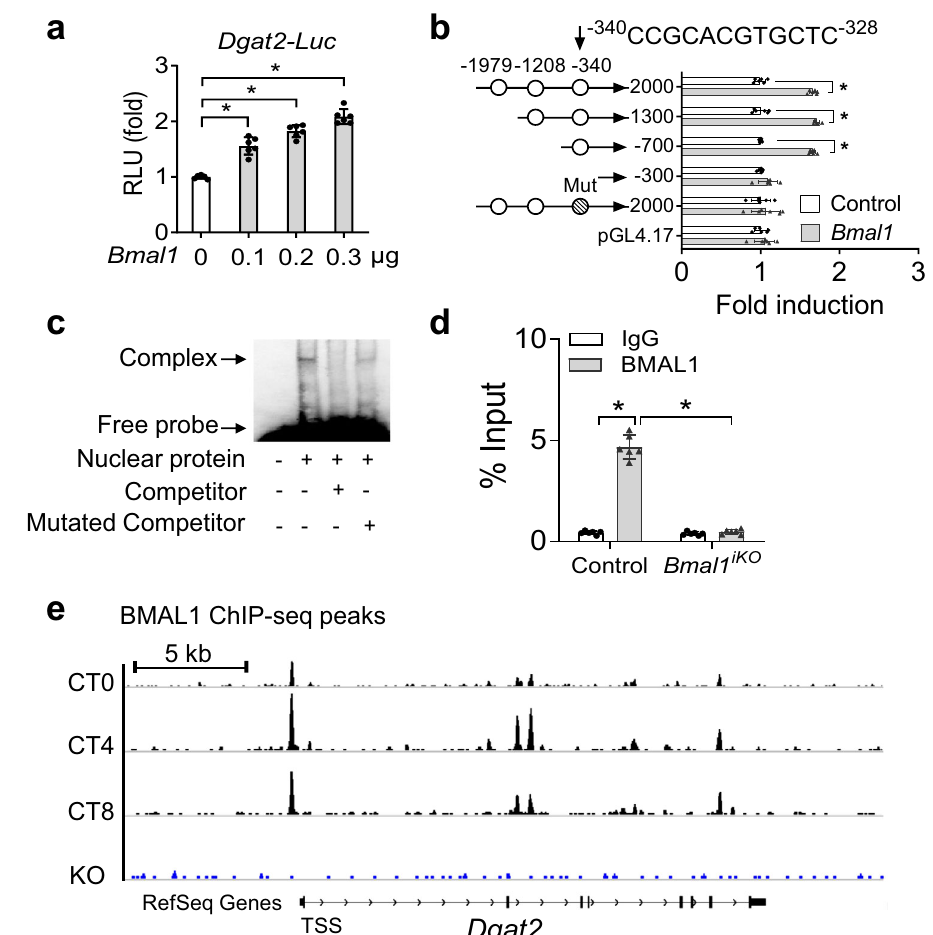
Fig. 6 BMAL1 regulates the transcription of Dgat2 . a Bmal1 dose-dependently induced Dgat2 transcription in luciferase reporter assays. NIH3T3 cells were transfected with Dgat2 -luc reporter and different amounts of Bmal1 plasmid. After 24 h transfection, luciferase reporter activities were measured. p values (from left to right): <0.0001, <0.0001, <0.0001, and <0.0001 (one-way ANOVA and Bonferroni post hoc test). b Effects of Bmal1 on the activities of various versions of Dgat2 -luc reporters. Two-sided t test p values (from top to bottom): <0.0001, <0.0001, <0.0001, 0.1811, 0.4680, and 0.4431. c EMSA assays showing a direct interaction between BMAL1 protein and Dgat2 E-box element. d ChIP assays showing signi fi cant recruitment of BMAL1 protein to Dgat2 E-box in the small intestine of control mice, but no such recruitment in the small intestine of Bmal1 iKO mice. p values (from left to right): <0.0001 and 0.2031 (two-way ANOVA and Bonferroni post hoc test). e ChIP-seq showing enrichment of BMAL1 protein to Dgat2 promoter (data obtained from GEO database with an accession number of GSE130505). All data points are mean ± SD ( n = 6 biologically independent samples). *represents a p value of